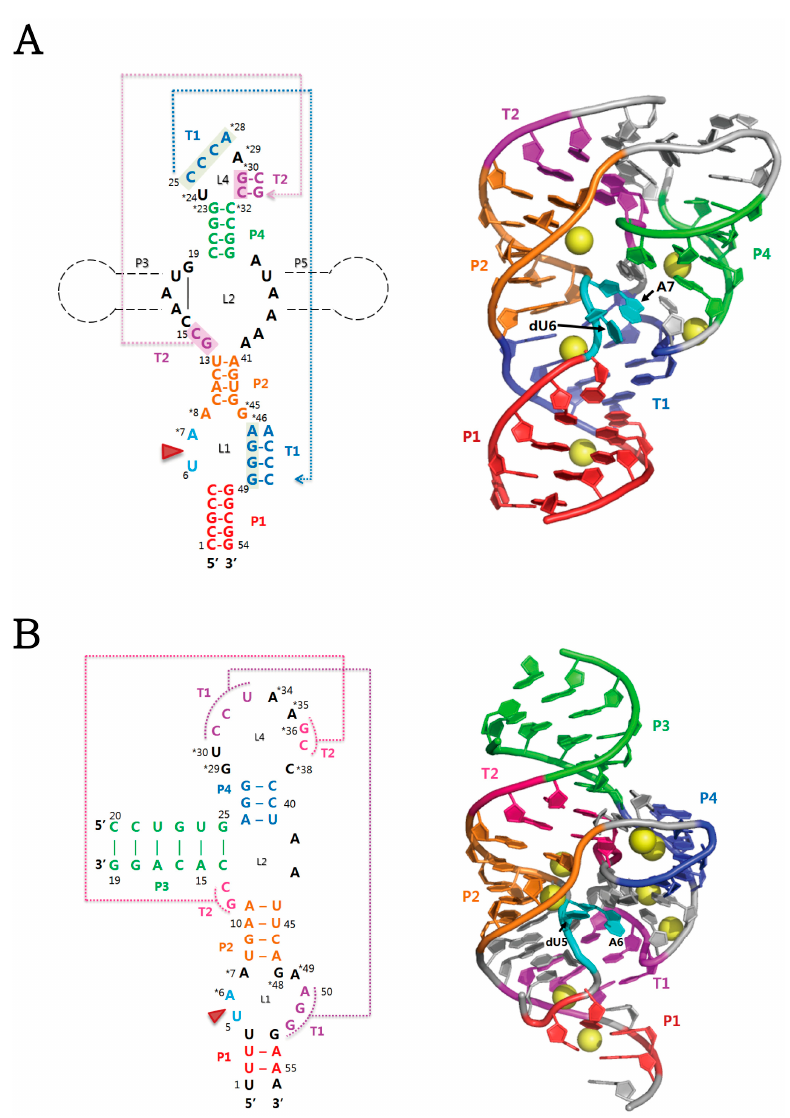
Figure 1. Secondary and tertiary structures of two representatives of twister ribozymes. ( A ) The structure of the twister ribozyme from O. sativa [30]. Additional stem-loop segments, P3 and/or P5, can be generated, as shown in black dotted lines; ( B ) The structure of the env22 twister ribozyme [29]. In ( A ) and ( B ), red arrowhead indicates the U-A cleavage site. On the secondary structure, highly conserved nucleotides (>97%) are marked by asterisks. Stems (P1-P4) and pseudoknots (T1 and T2) are colour-coded in the tertiary structure. In particular, two nucleotides at the cleavage site and bound magnesium ions are coloured in cyan and yellow, respectively. Protein Data Bank (PDB) accession codes for ( A ) and ( B ) are 4OJI and 4RGE, respectively.